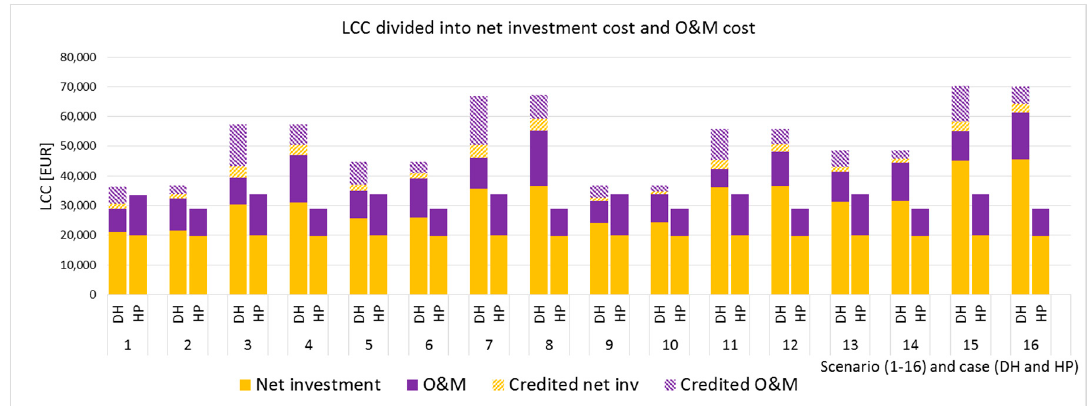
Figure 5. The LCC divided into net investment cost and O&M cost, for both the DH and HP case, respectively, for all 16 scenarios. The credited cost for electricity production using CHP is shown in the DH case. The cost where the credited electricity production is included should be read as the filled bar only.